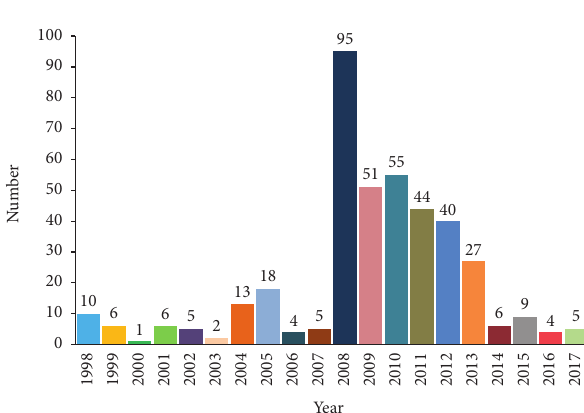
Figure 1: The number of EV-A71 isolated strains with the complete genome in different years in China. The height of the histogram represents the number of isolates, and the number on the histogram indicates the number of EV-A71 isolated